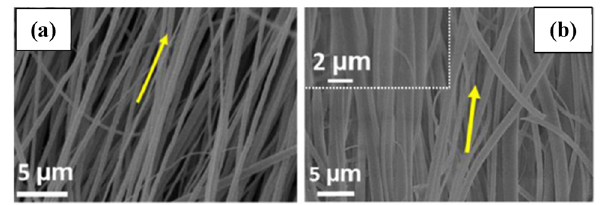
Figure 11: SEM images of ( a ) aligned B - CA nano fi bres and ( b ) CNFs after regeneration. Adapted from ref. [ 67 ]